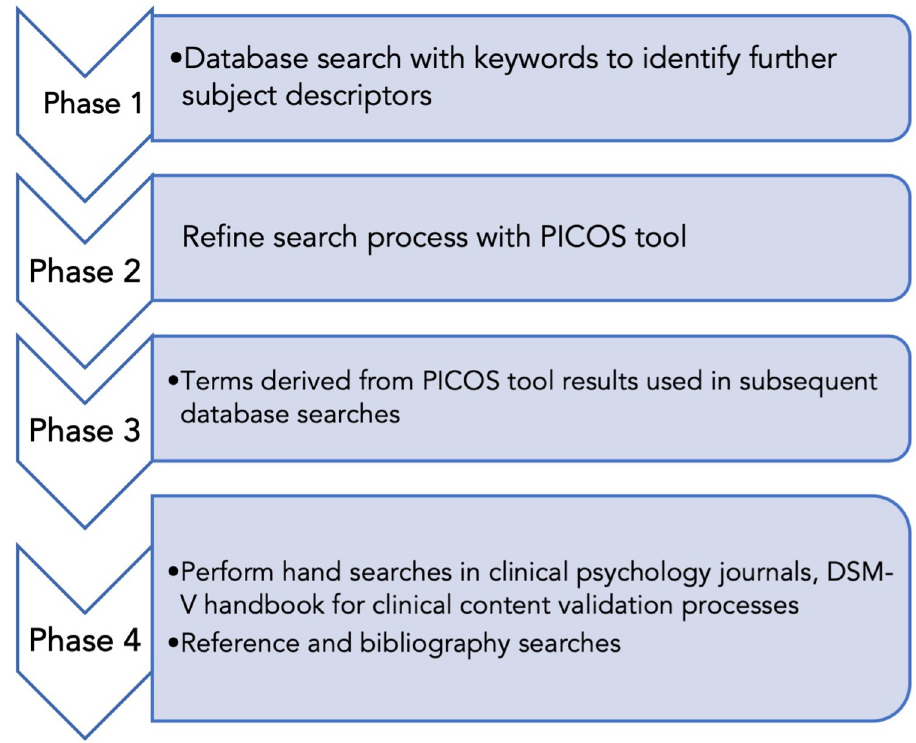
Fig 2. Key phases in literature